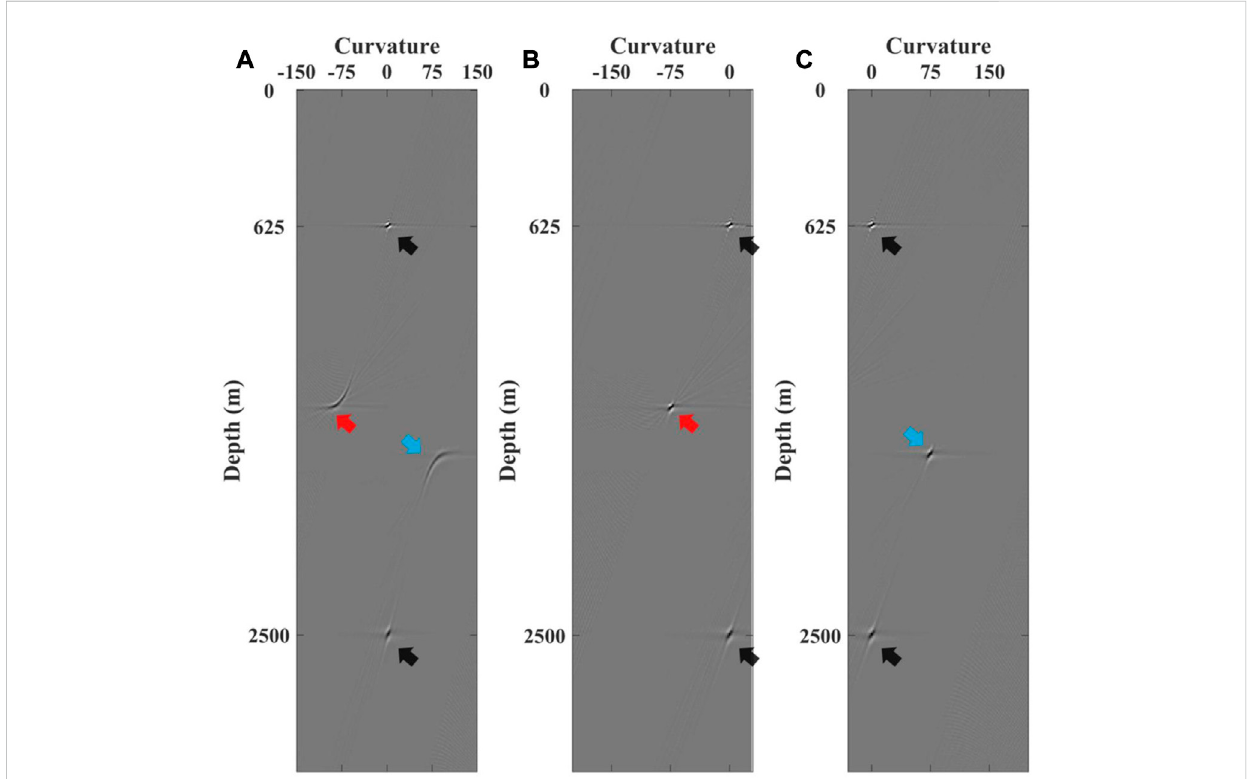
FIGURE 10 Comparison of Radon transform for angle gathers using tangent square approximation and two RMO equations. (A) Results of Radon transform for two types of crosstalk using tangent square approximation equation as kernel function, (B) Results of Radon transform for anti-causal crosstalk using derived RMO equation of anti-causal crosstalk as kernel function, (C) Results of Radon transform for causal crosstalk using derived RMO equation of causalcrosstalkasthekernelfunction.TheblackarrowsindicatethelocationoftheactualimagingintheRadondomain.Theredarrowsindicatethe location of anti-causal crosstalk in the Radon domain. The blue arrows indicate the location of causal crosstalk in the Radon